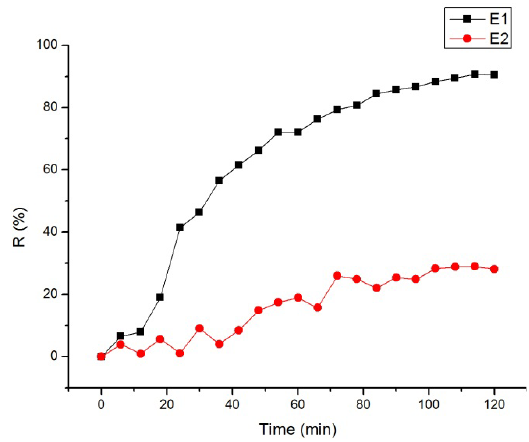
Figure 4. Removal efficiencies of E1 and E2 under UV photolysis.